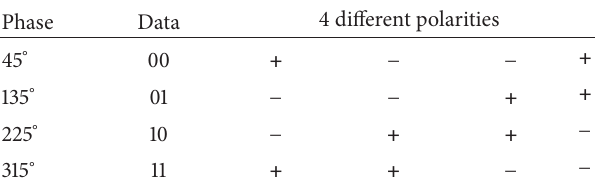
Table 1: Combinational polarities for QPSK